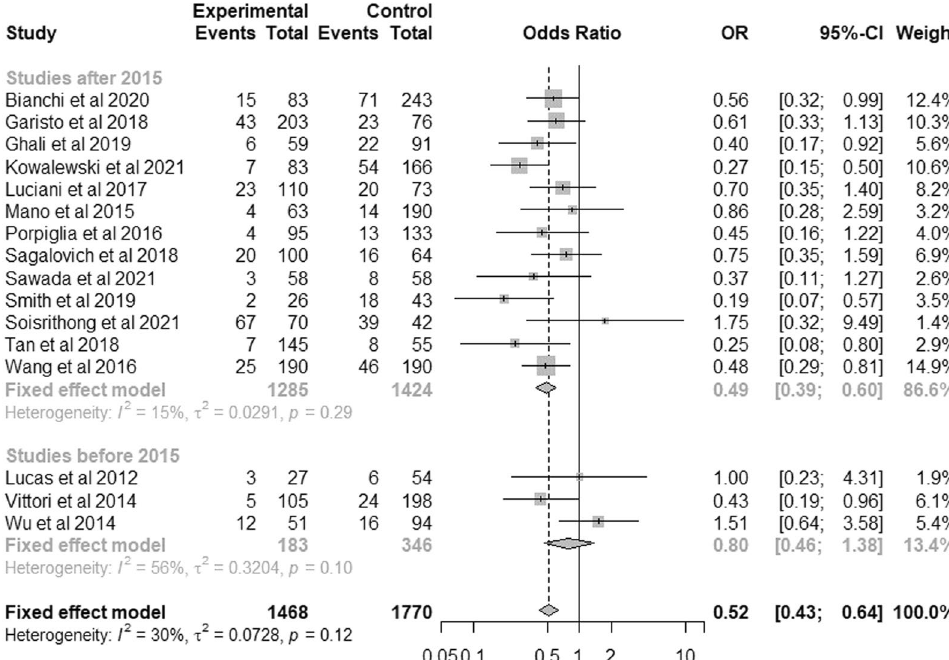
Fig. 6 Forest plot under the fixed effects model for the subgroup analysis based on whether each study was published before or after 2015. The subgroup analysis demonstrates a statistically significant reduction in the odds for mild postoperative complications (CD: I and II) in robotic compared to the open approach only for those studies published after 2015 ( peto OR classification of postoperative